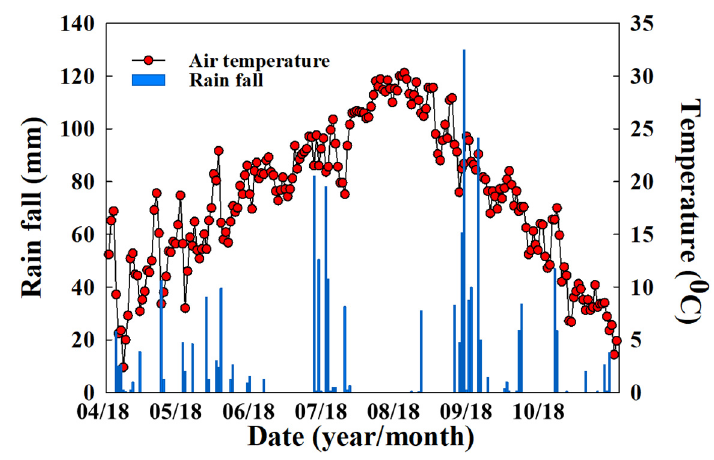
Figure 2. Air temperature and precipitation during the cultivation period. Table 6. Cumulative N 2 O-N and CO 2 -C emission amounts based on a monthly measured gas emission